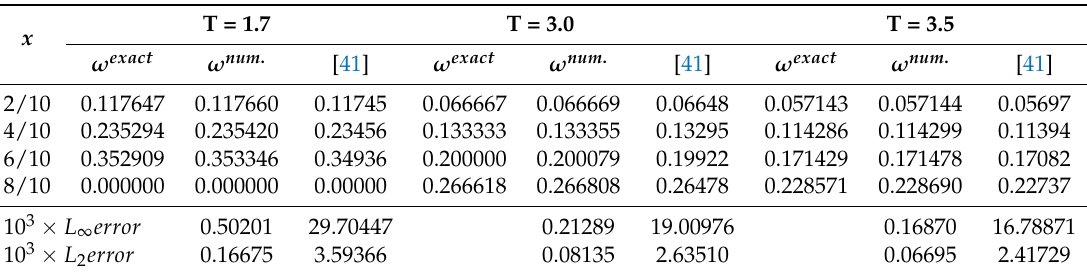
Table 7. Comparison of results by present method and existing method and its error for ν d = 0.002, h = 0.0005 and τ = 0.01 at different T for problem